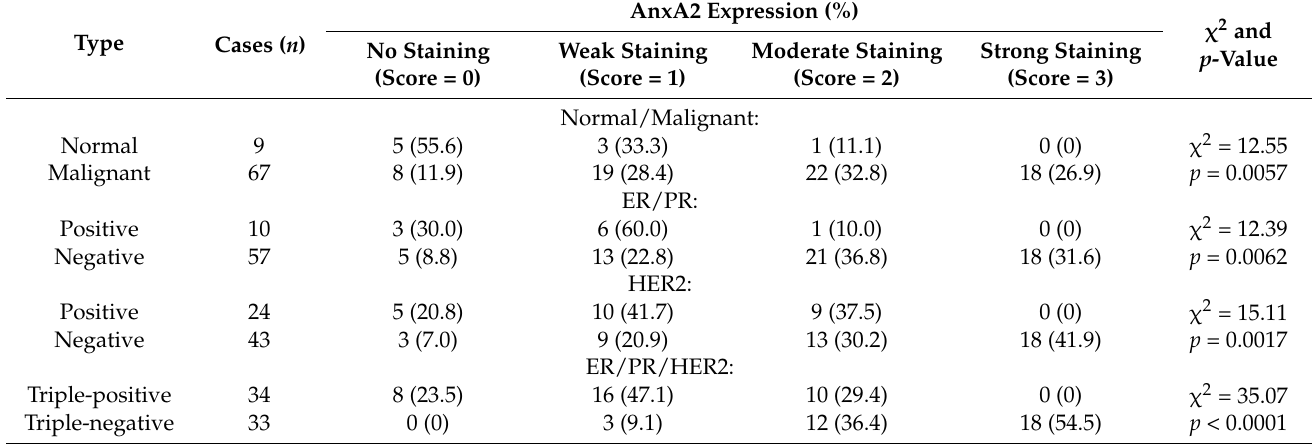
Table 1. Immunohistochemistry (IHC) scoring of breast tissue